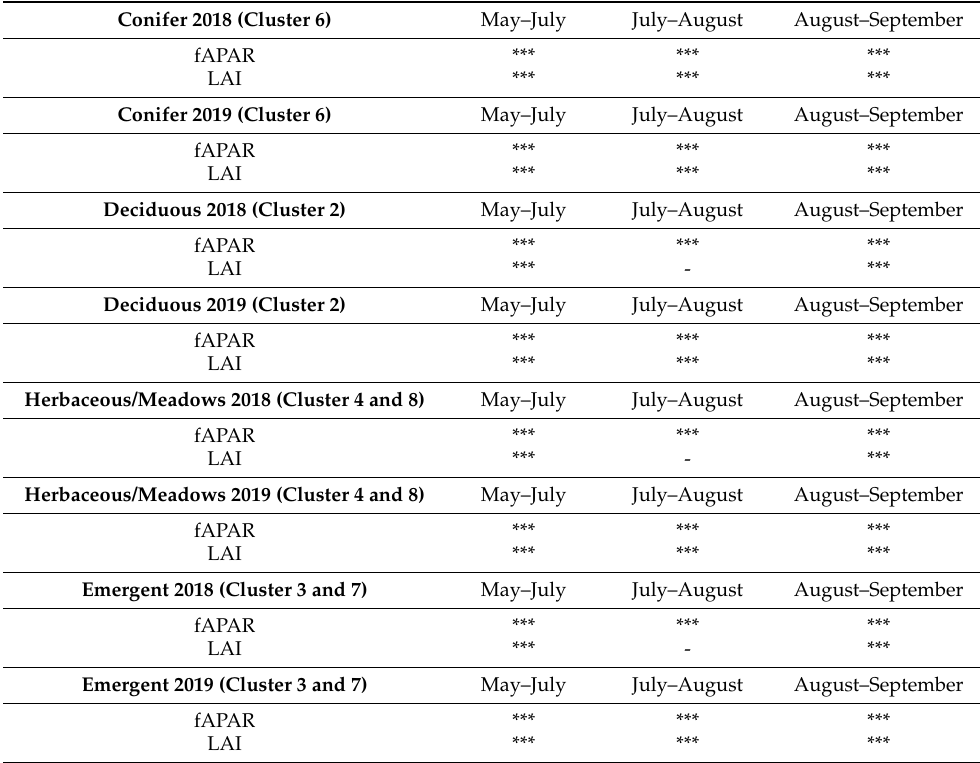
Table A4. Kruskal–Wallis test results for comparison of separation metrics (LAI and fAPAR) based on vegetation cover class/clusters through time for LAI between adjacent image acquisitions dates. The presence of *** denotes that the null hypothesis was rejected and that the samples are significantly different at p = 0.05